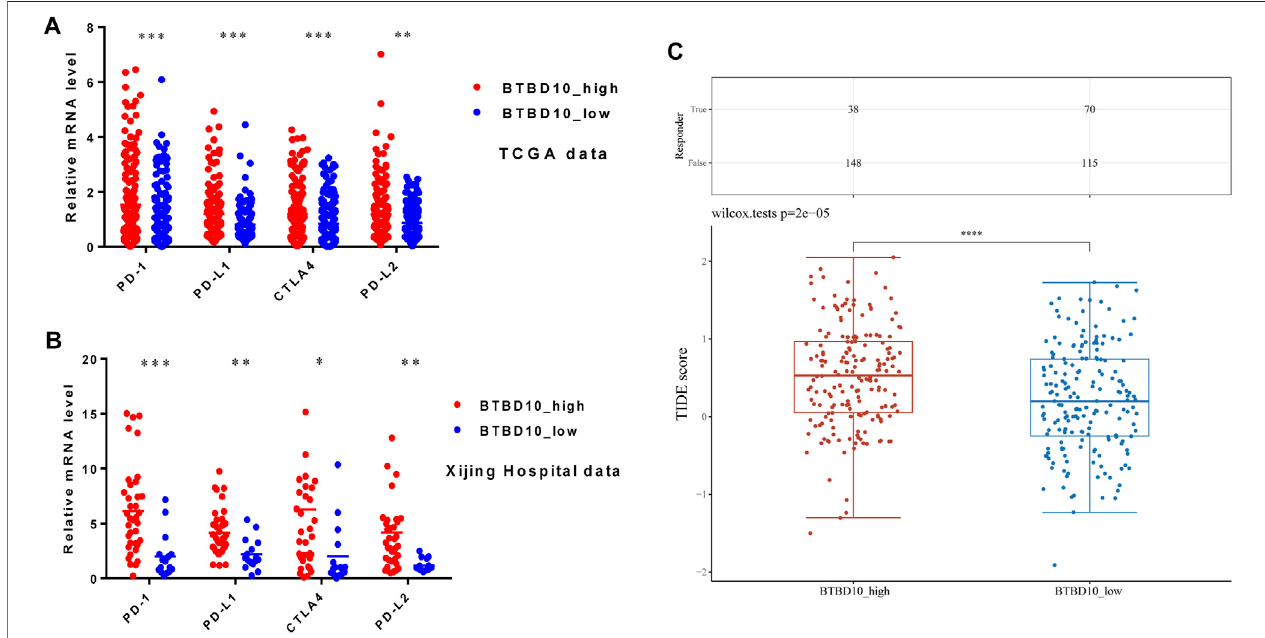
FIGURE7| Expressiondistribution ofimmunecheckpointgenesindifferentBTBD10expression groups (A) TCGAdata; (B) XijingHospitaldata; (C) TIDEalgorithm was used to obtain the statistical table of immune response and the distribution of immune response scores in different groups.